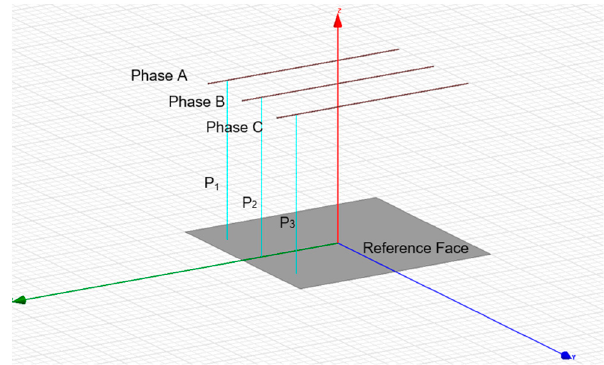
Figure 4. Three-phase overhead line simulation model.